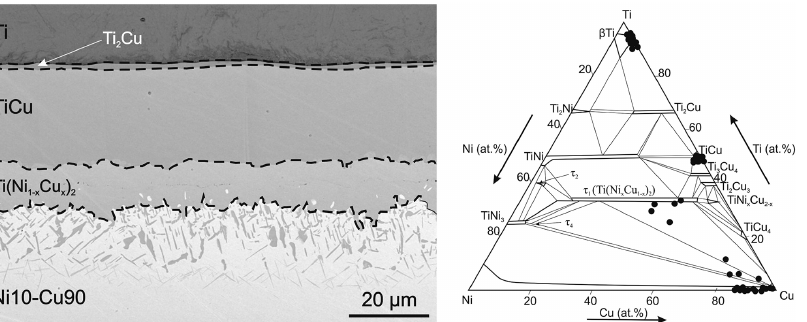
Figure 1: Left – the microphotography showing grown intermetallic phases, right – the diffusion path in diffusion couple experiment Ti-Ni10Cu90 at 1,123 K after 160 h.